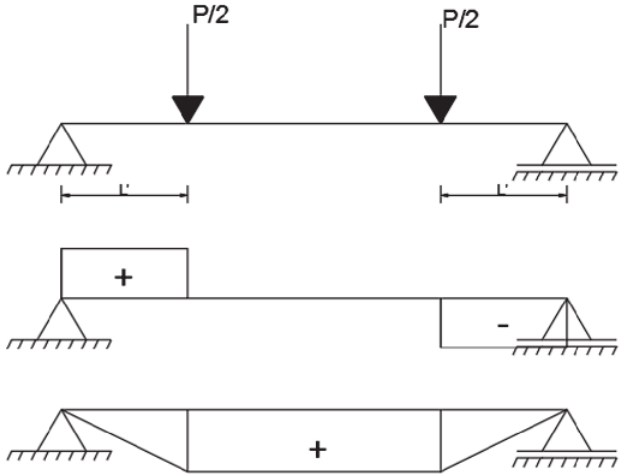
Modelo de ensaio à flexão de quatro pontos com diagramas de cortante e